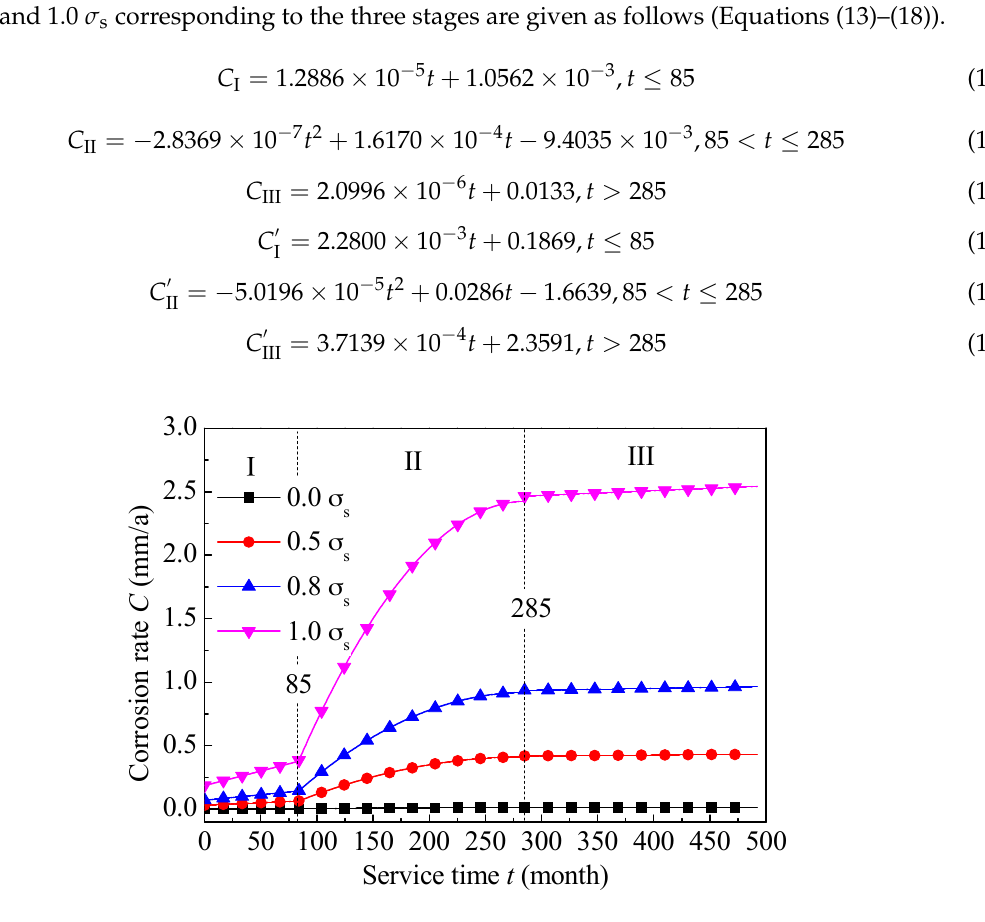
Figure 10. Corrosion rates of L80 steel as a function of service time under different preloading stress.